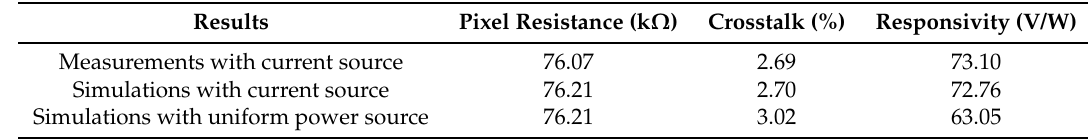
Table 1. Comparison between experimental and simulation results. Numerical simulations were implemented using both a current source and an uniform heat source across the thermopile elements.